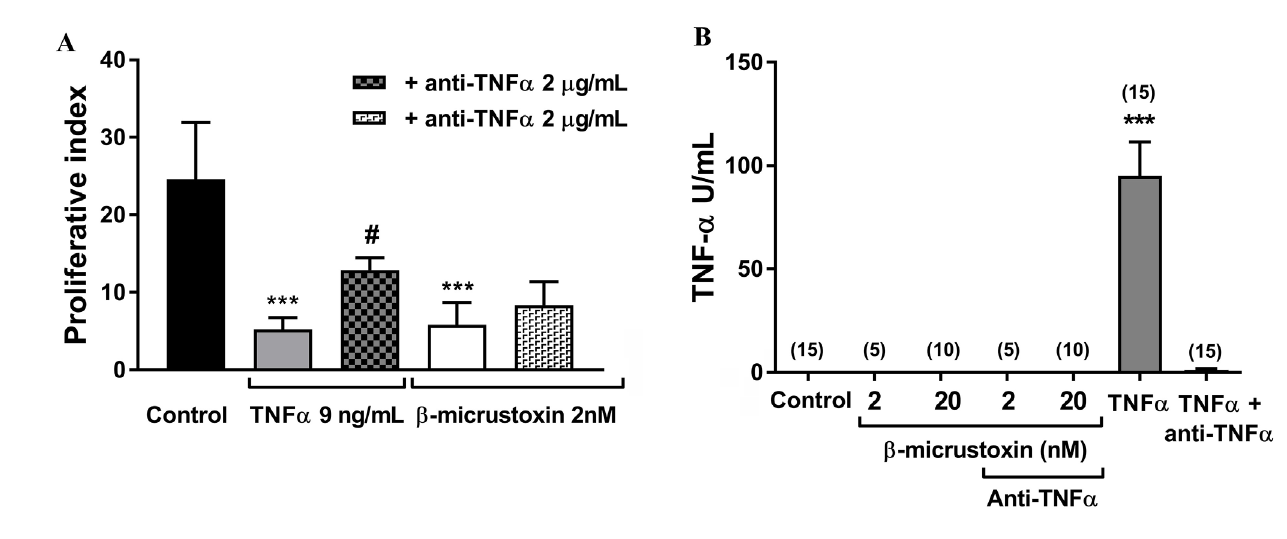
Figure 11. TNF-α is not involved in the reduction of astrocyte proliferation by β-micrustoxin. (A) Proliferative index of cultured astrocytes incubated in the absence (control) or presence of 2 nM β-micrustoxin or 9 ng/mL TNF-α and associated or not with 2 µg/mL anti-TNFα. One-way ANOVA: p < 0.0001; Bonferroni post-hoc test: ***p < 0.001 in relation to control group; #p < 0.05 in relation to TNFα. N = 4/group. (B) TNF-α released by cultured astrocytes was evaluated by the fibroblast cell line L929 assay. Cultured astrocytes were incubated in the absence (control) or presence of 2 or 20 nM β-micrustoxin or 9 ng/ mL TNF-α and associated or not with 2 µg/mL anti-TNFα for 5 h. L929 cells were incubated with the astrocyte supernatant and TNF-α was quantified. One-way ANOVA; Bonferroni post-hoc test: ***p < 0.001. N is expressed in parentheses; two full experimental blocks.